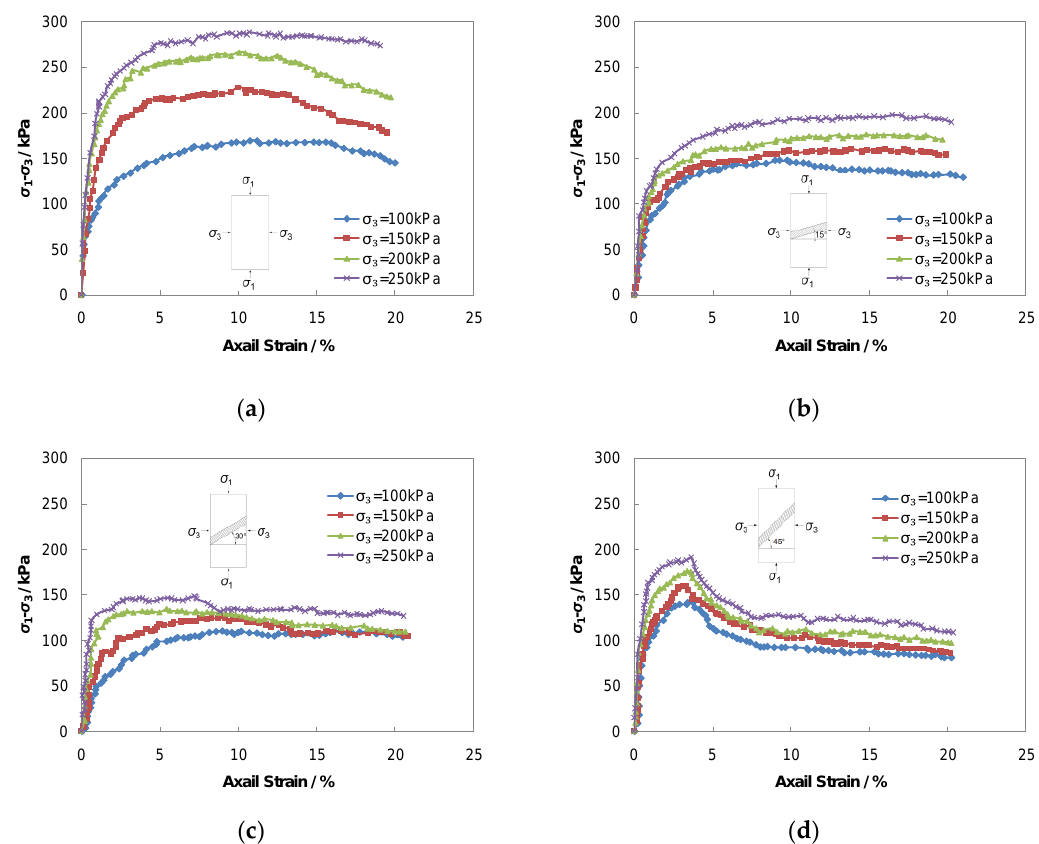
Figure 6. Stress–strain curve of the triaxial test. ( a ) Without a filled fissure; ( b ) filled fissure with an inclination angle of 15°; ( c ) filled fissure with an inclination angle of 30°; ( d ) filled fissure with an inclination angle of 45°.